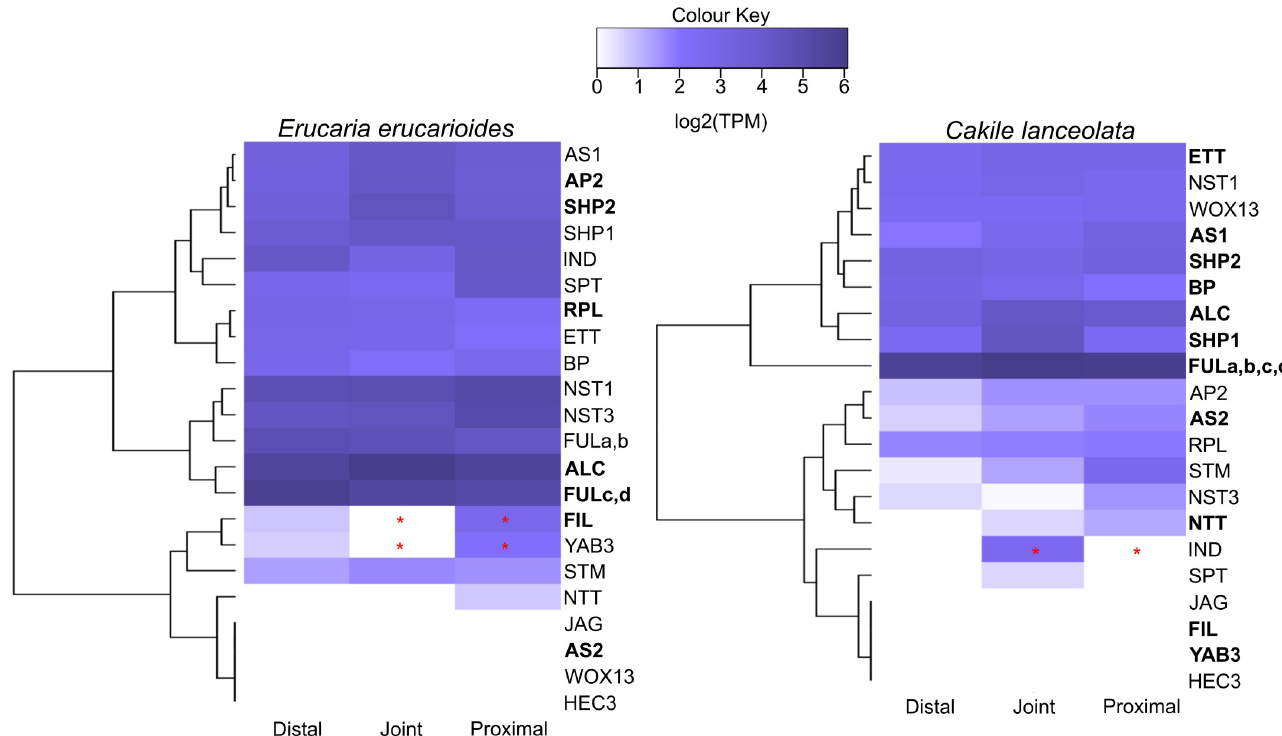
Fig 6. Heatmap of edgeR contig clustered transcripts from Erucaria erucarioides and Cakile lanceolata expressed in log2 (TPM) with TMM normalization. Representative transcripts are those with the highest bitscore hit against the TAIR database. Bolding indicates shared orthogroup with other transcriptome. FULa, b,c,d are copies of FUL that are present in some species across the Brassicaceae [71]. TPM, Transcripts Per Million; TMM, Trimmed Mean of M-values. Asterisks indicate significant differential expression between proximal and joint region. (FDR-corrected α = 0.01).